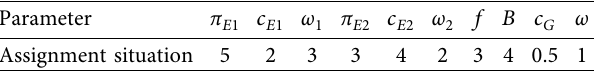
Table 7: Assignment of each parameter.